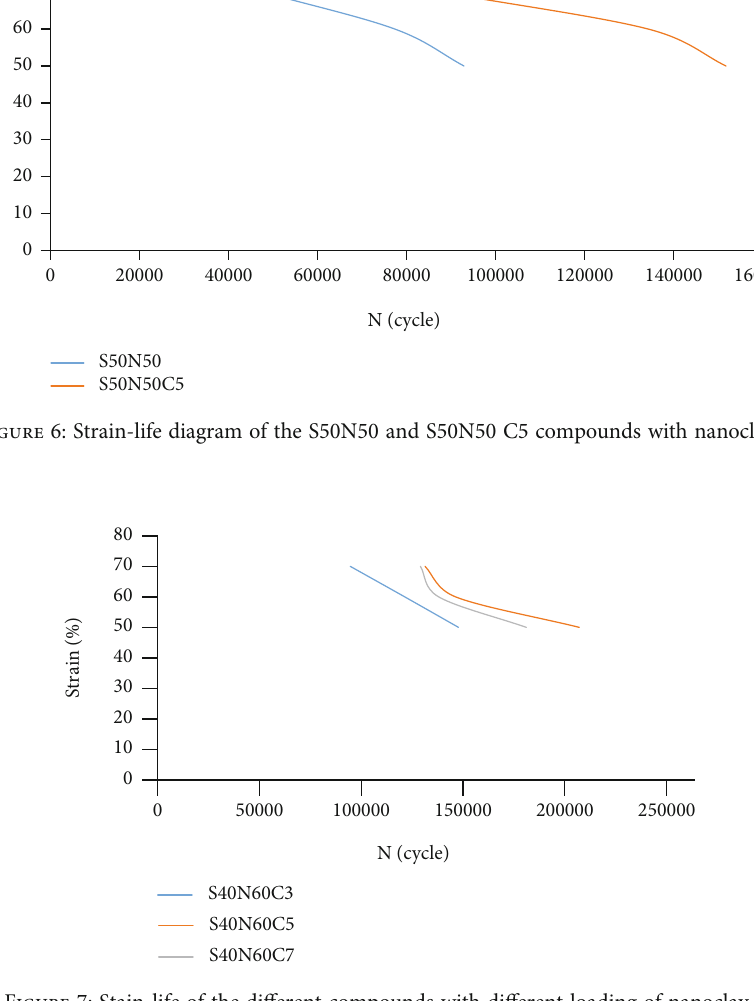
Figure 7: Stain-life of the di ff erent compounds with di ff erent loading of